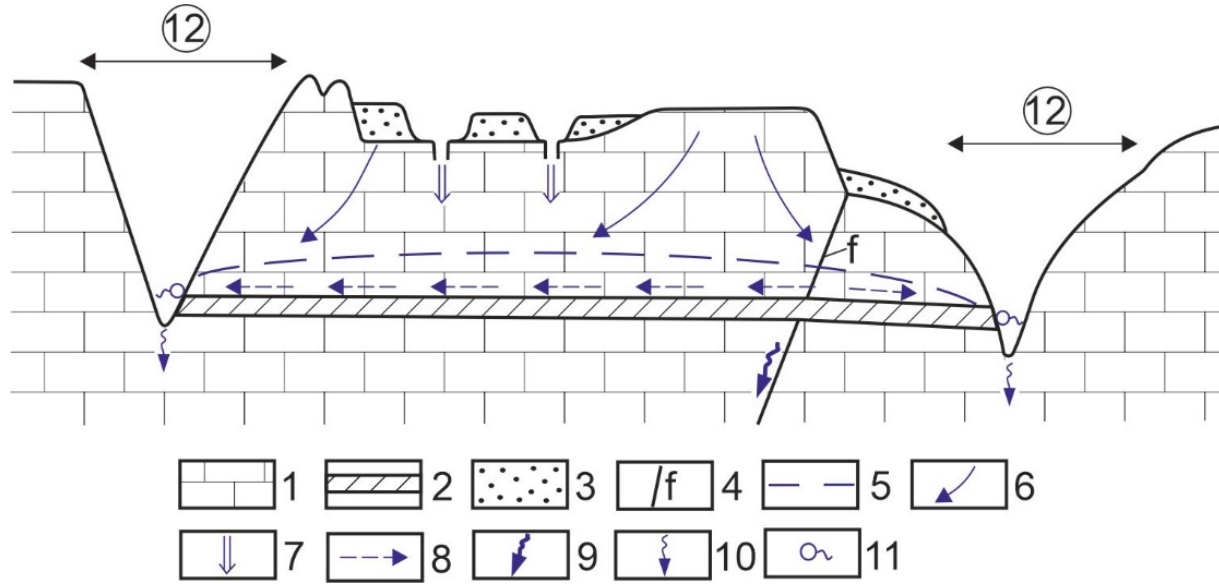
Figure 10. Closed epigene karst system in cross-section. Legend: 1. Limestone, 2. Impermeable intercalation, 3. Permeable cover, 4. Fault, 5. Groundwater level, 6. Infiltration, 7. Local water inflow, 8. Water motion above aquifuge, 9. Water drainage along fault, 10. Linear seepage, 11. Spring, 12. Epigenetic valley.